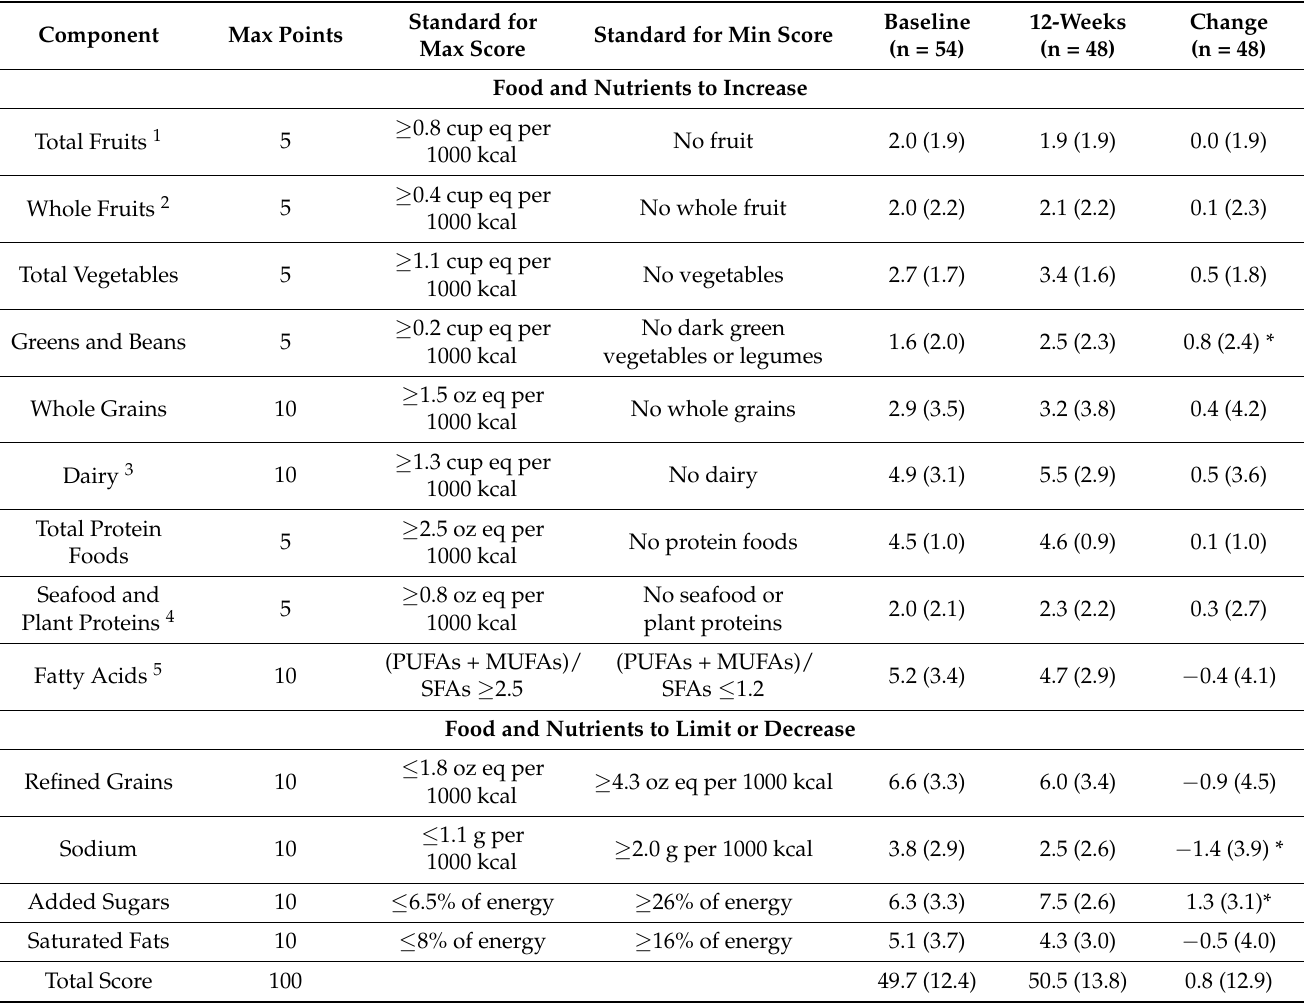
Table 4. Changes in total and component Healthy Eating Index-2015 scores among caregivers enrolled in WIC participating in the Healthy Roots